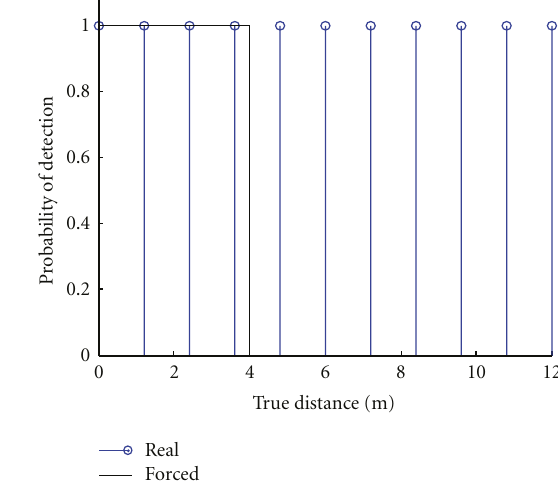
Figure 5: Path-loss exponent estimation.